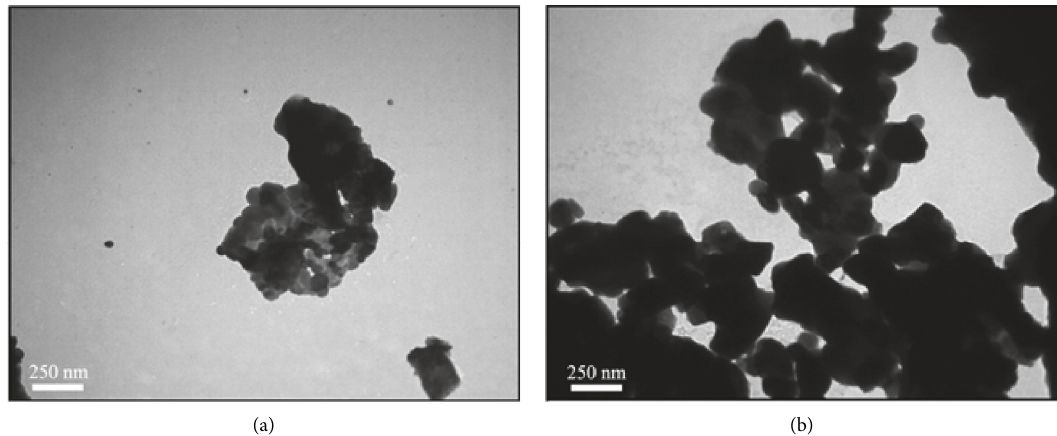
Figure 11: TEM images of (a) Ni